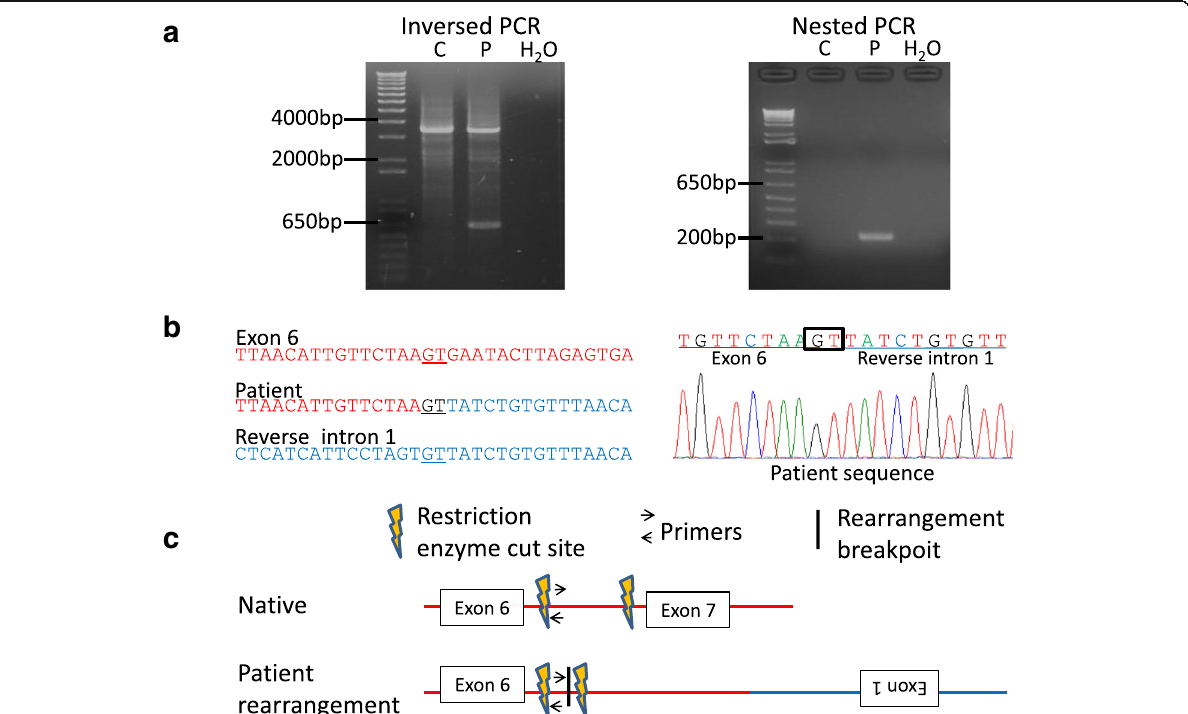
Fig. 2 Identification of the duplication junction via inverse PCR. a Isolation of the junction fragment. Two distinct inverse PCR products were observed following agarose gel electrophoresis. The larger product was derived from a normal allele and the small product from a rearranged allele (left). The amplified products were purified following nested PCR (right). P, patient; C, control; H, H 2 O. b Sanger sequencing of the PCR products including the junction. The unknown sequence next to the junction was identified as intron 1 of the OTC gene in the reverse orientation. The normal exon 6 and intron 1 sequences are aligned in red and blue typeface, respectively. Underlined nucleotides indicate microhomology at the breakpoint junction. c Predicted structure of the junction. Horizontal arrows indicate the recognition sites of the primers used for inverse PCR and the vertical arrows denote the Taq I restriction